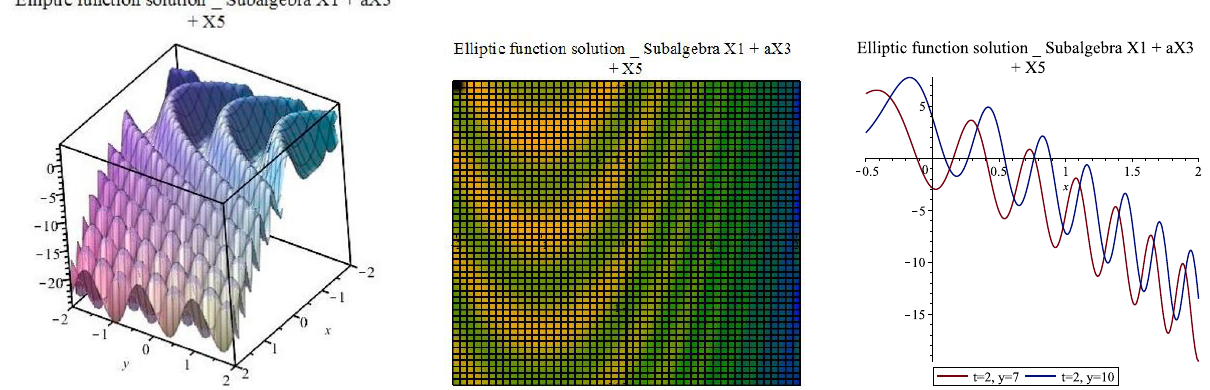
Figure 15. Solitary wave profile depiction of elliptic solution (84) at t = 2.